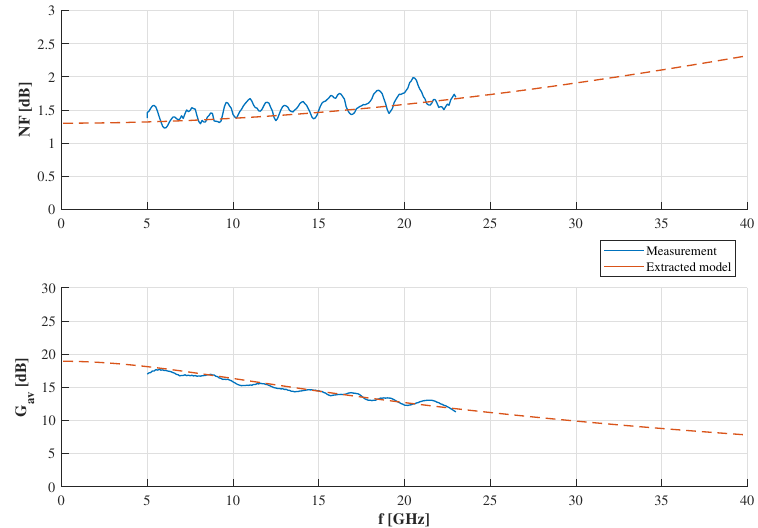
Figure 4. Noise figure (NF) and associated gain of a 2 × 50 µ m device at V DS = 5 V, V GS = − 1.25 V, Id = 31 mA: measurements versus simulations.